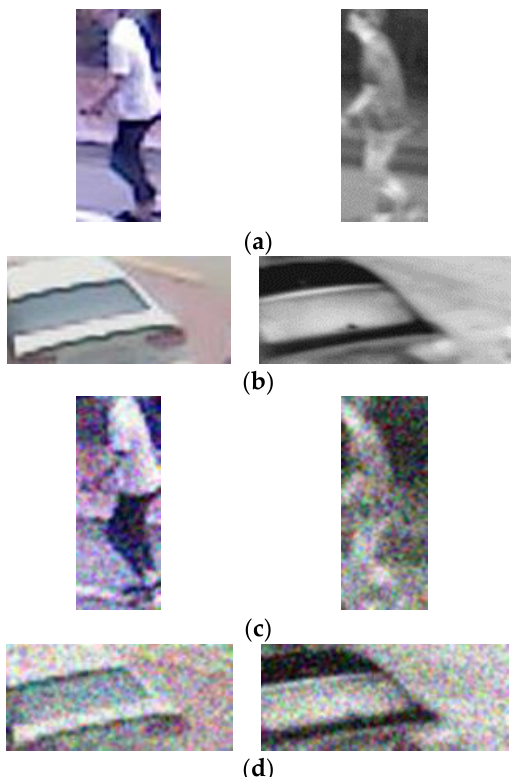
Figure 11. Examples of original and degraded DVLFPD-DB1. Original images of ( a ) pedestrian candidate, and ( b ) non-pedestrian candidate. Degraded images of ( c ) pedestrian candidate, and ( d ) non-pedestrian candidate. In ( a – d ), left and right images show the candidates from visible light and FIR light images, respectively.